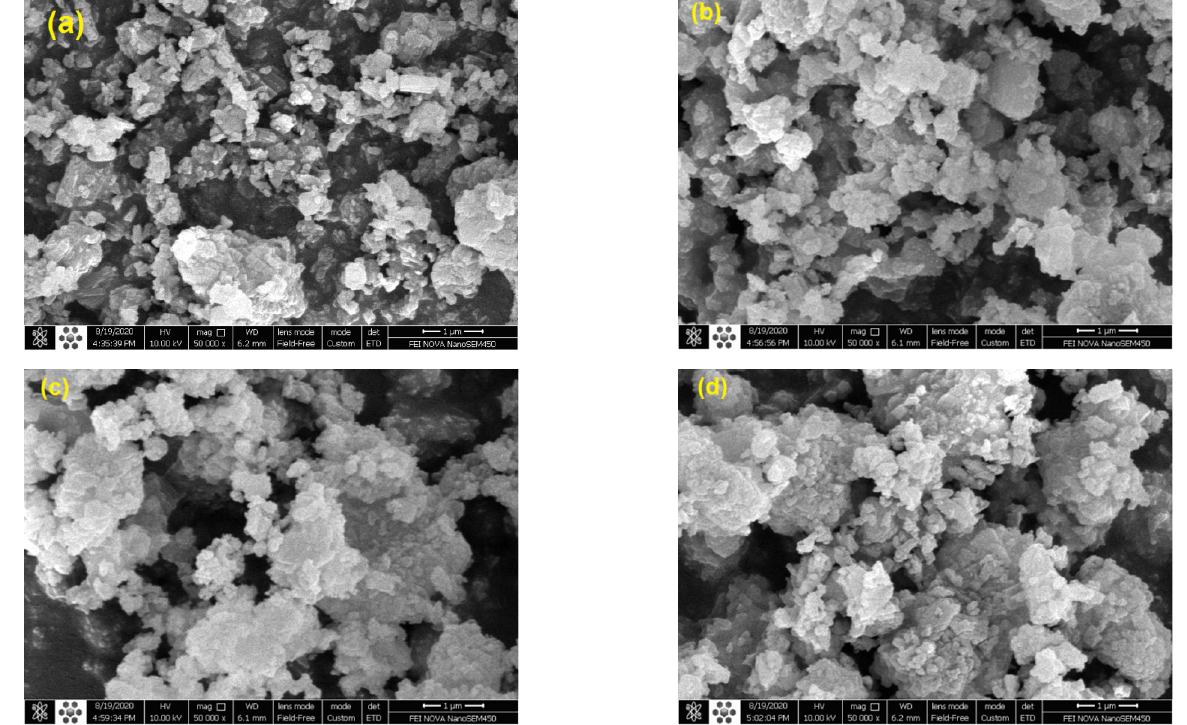
Figure 10. SEM images of HZSM-5 ( a ), (2.5%La-7.5%Ce)/HZSM-5 ( b ), (5%La-5%Ce)/HZSM-5 ( c ), and (7.5%La-2.5%Ce)/HZSM-5 ( d ).